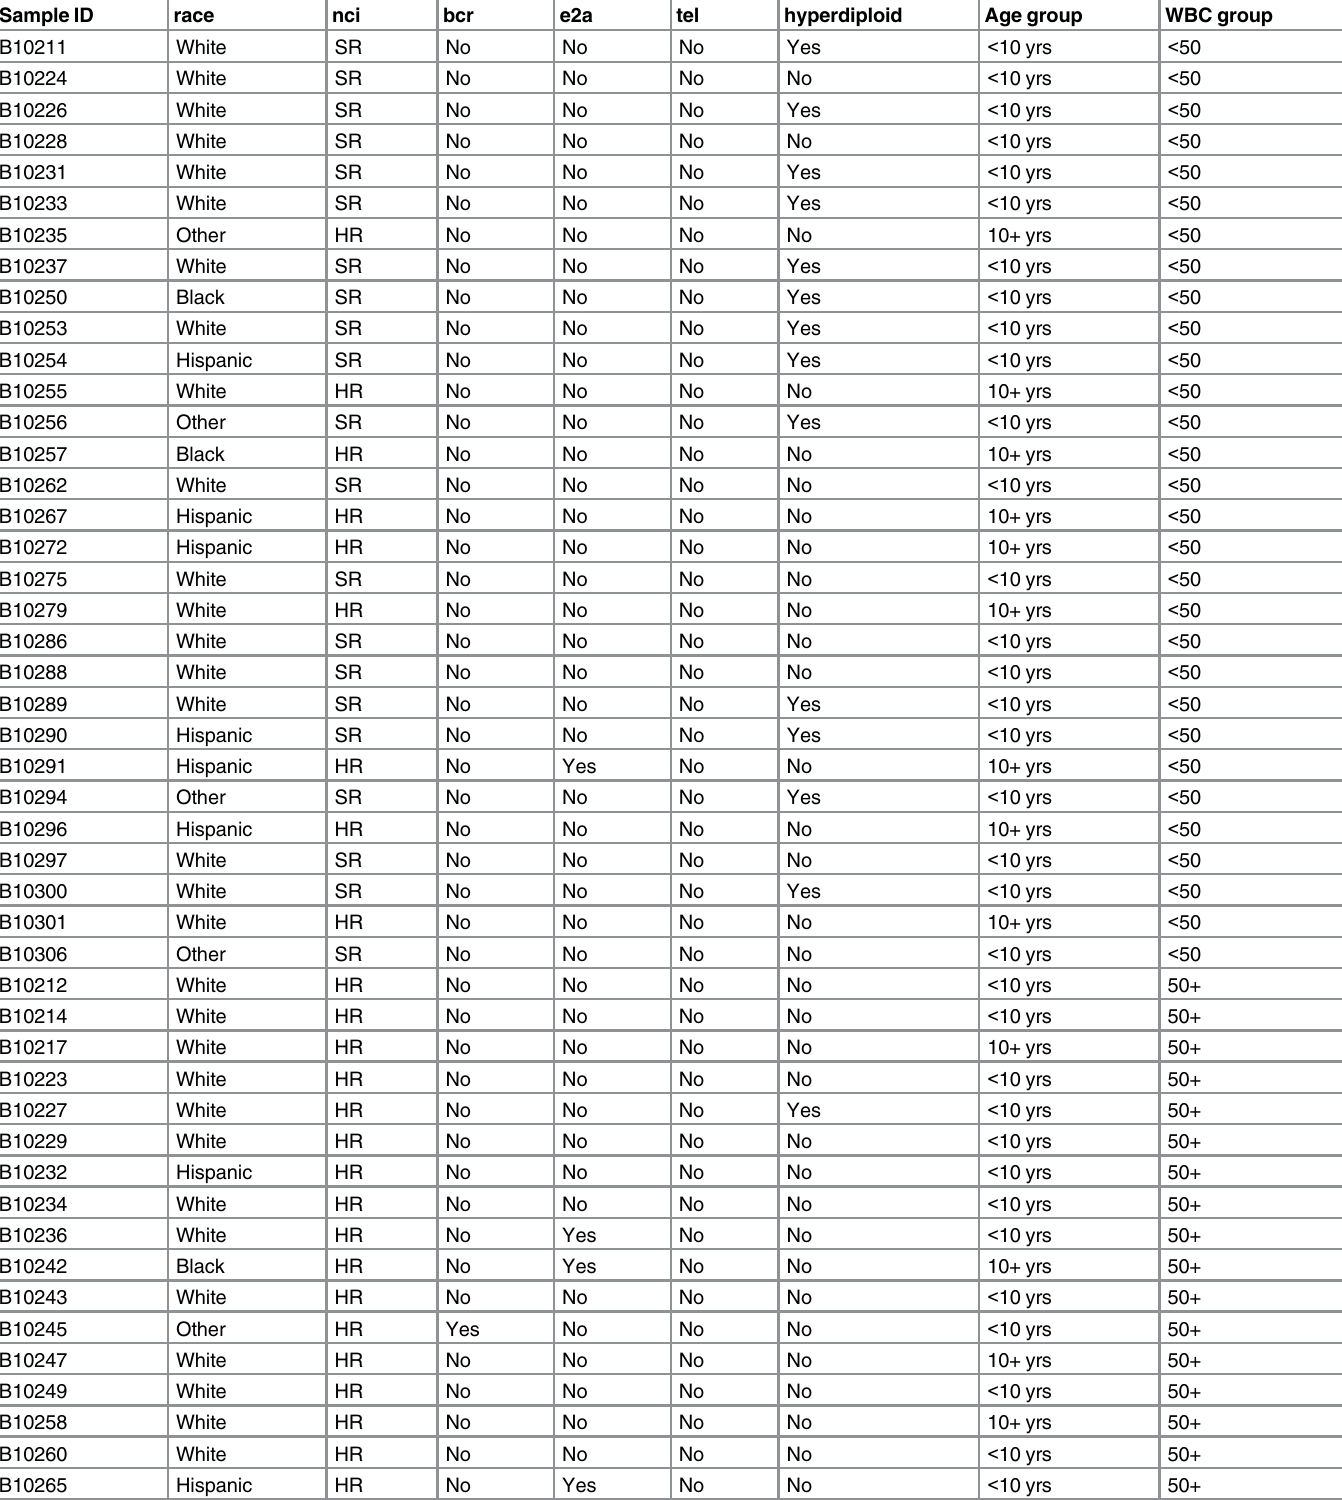
Table 2. ETV6-RUNX1 -negative patient